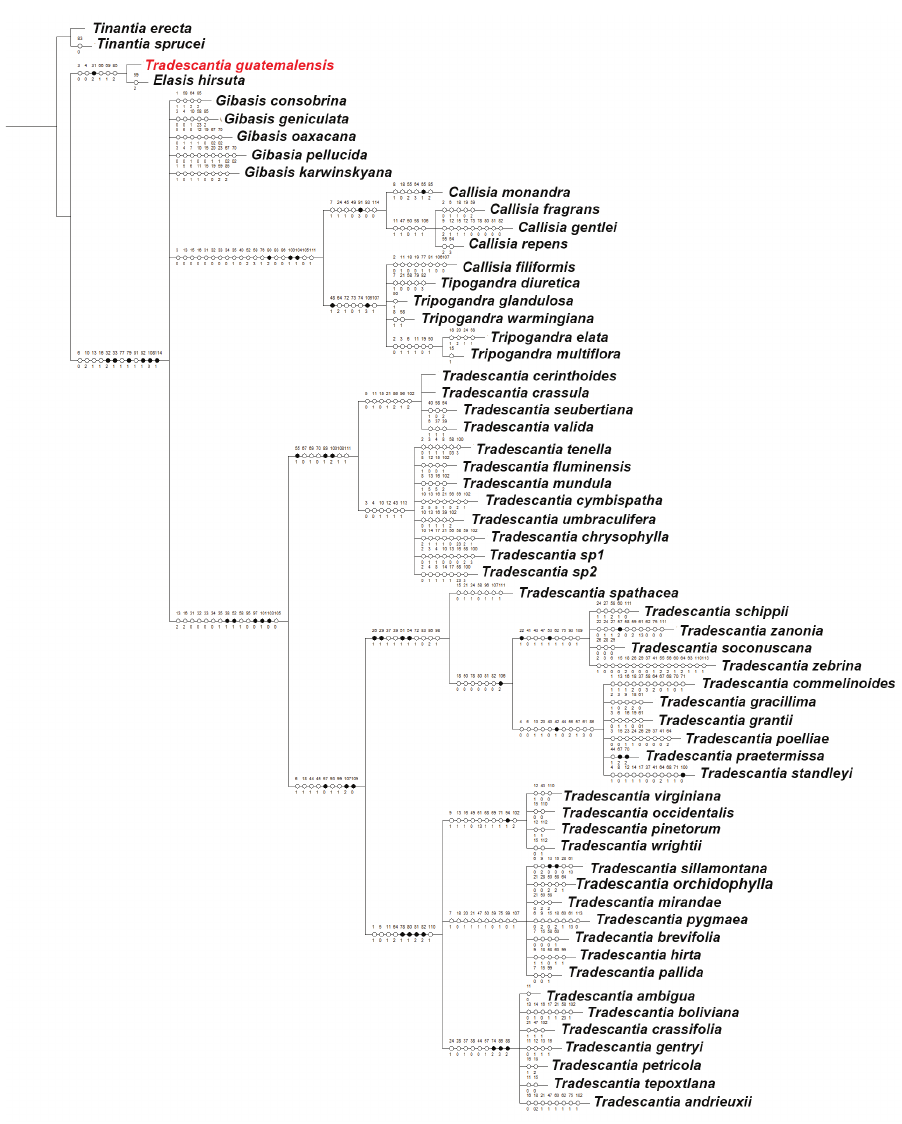
Figure 3. Strict consensus tree (length= 516 steps; CI= 0.3411; RI= 0.8039), showing the character state optimizations at each node of the cladogram, represented by circles. In each circle, the numbers above and below represent the character and character state numbers, respectively (as presented in Suppl. material 1). Tradescantia guatemalensis C.B.Clarke ex Donn.Sm. is depicted in red, to highlight its placement as sister to Elasis hirsuta (Kunth)